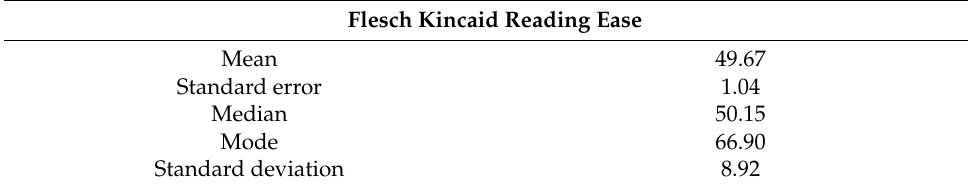
Table 4. Descriptive statistics of the Flesh Kincaid Reading Ease (FKRE)